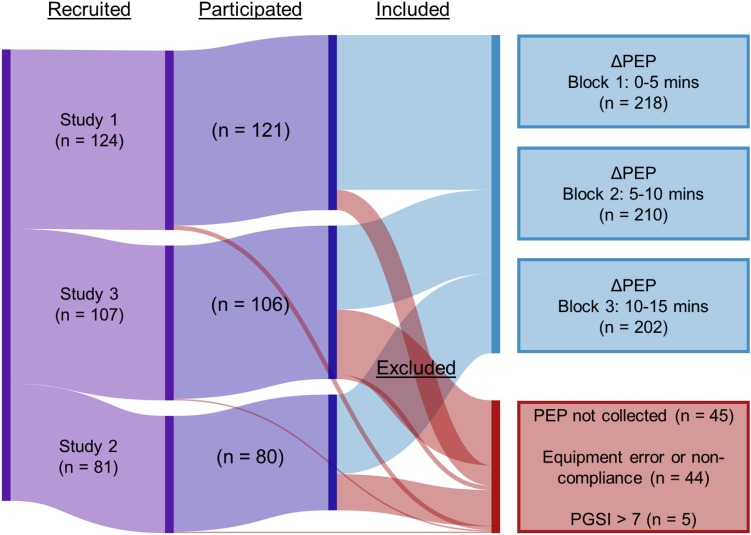
Inclusion flowchart.